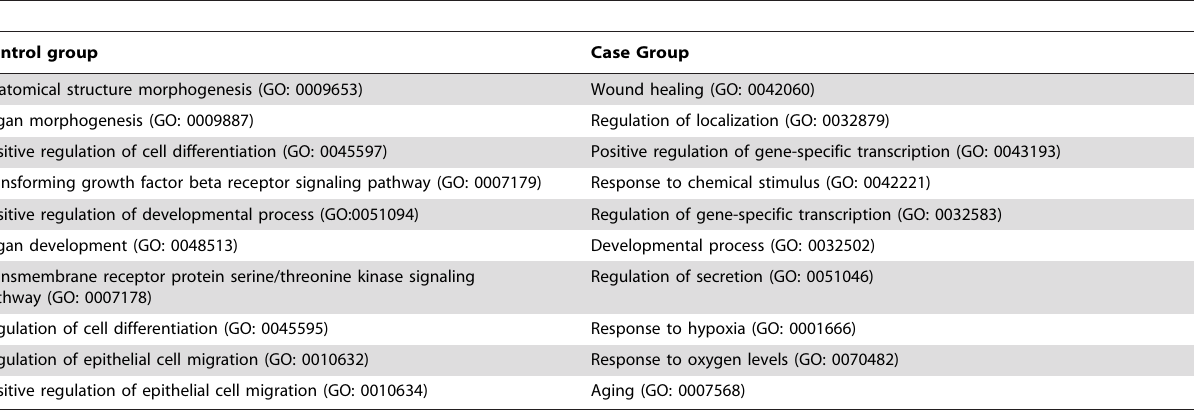
Table 4. Significantly enriched GO biological processes with respect to the SNAI1 associated deregulated